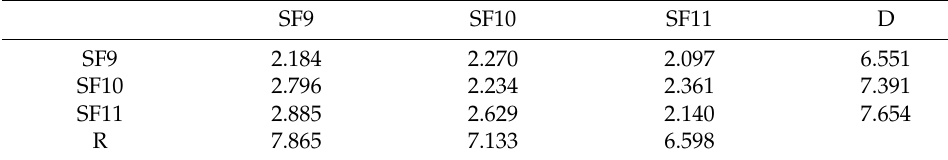
Table A6. Total influence matrix for Adaptability sub-criteria.